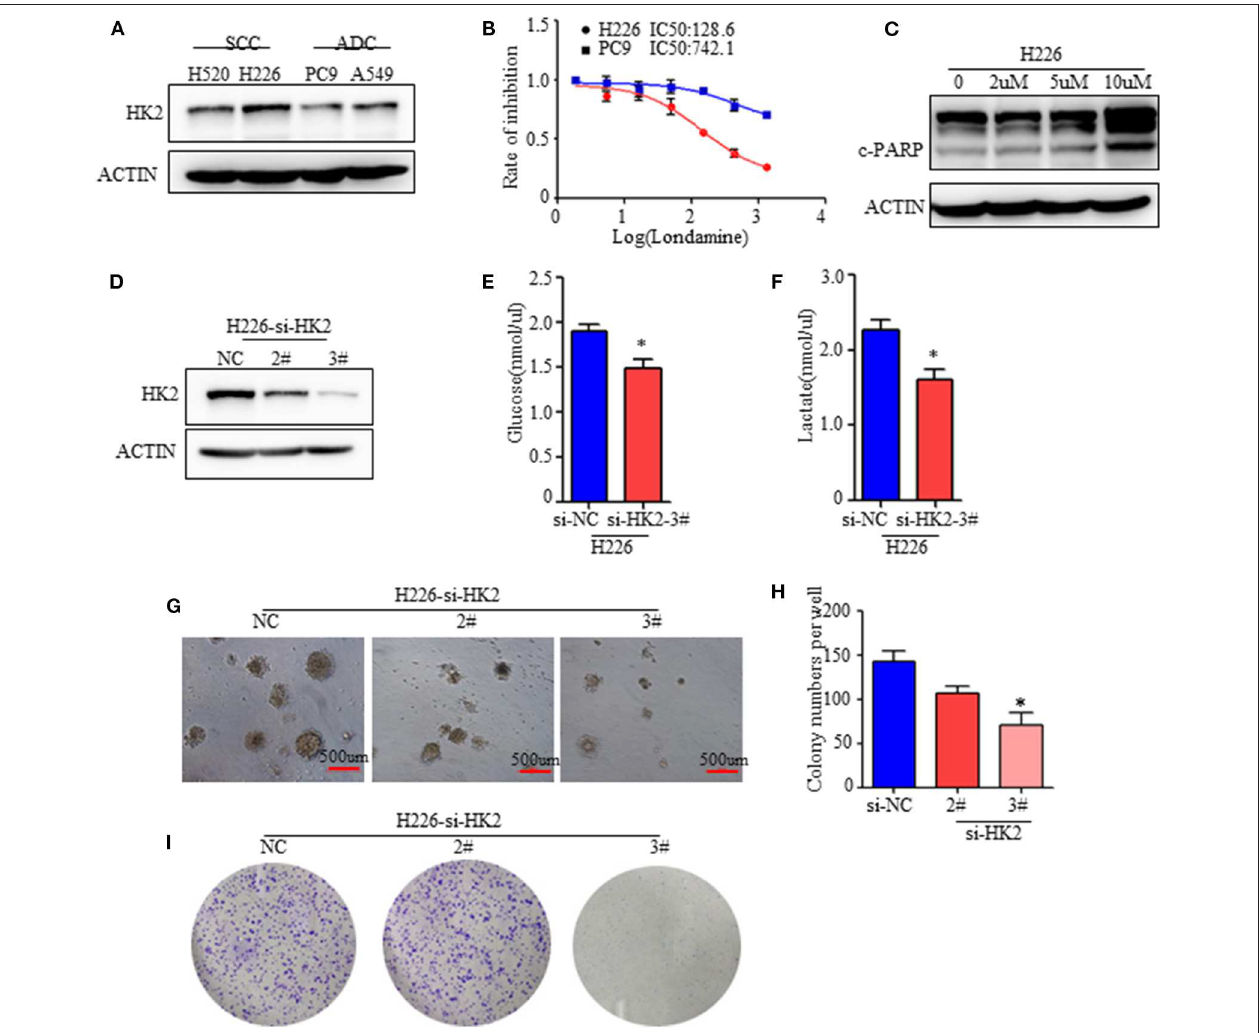
FIGURE 2 | HK2 contributes to lung squamous tumor cell growth. (A) Western blot showing the expression of HK2 in SCC and ADC cell lines. (B) Rate of inhibition in H226 and PC9 cells with or without lonidamine treatment. (C) Expression of cleaved-PARP in H226 cells treated with different doses of lonidamine. (D) Western blot showing the efficiency of silencing HK2 in the H226 cell line. (E,F) Glucose uptake and lactate production in H226 si-NC- and si-HK2-transfected cells using the Glucose and Lactate Colorimetric Assay Kit. (G) Colony formation assay showing anchorage-independent growth in H226 cells. (H) Colony formation numbers in H226-si-NC- and H226-si-HK2-transfected cells. (I) 2-dimensional colony formation assay of H226-siNC and H226-siHK2 cells. * p < 0.05.